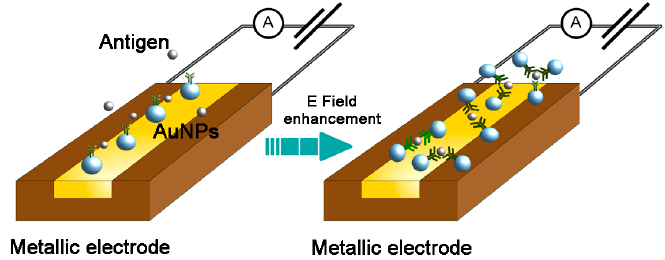
Figure 1. Schematic representation of gold nanoparticles applied in an electrochemical biosensor. E Field: electric field; AuNPs: gold nanoparticles.